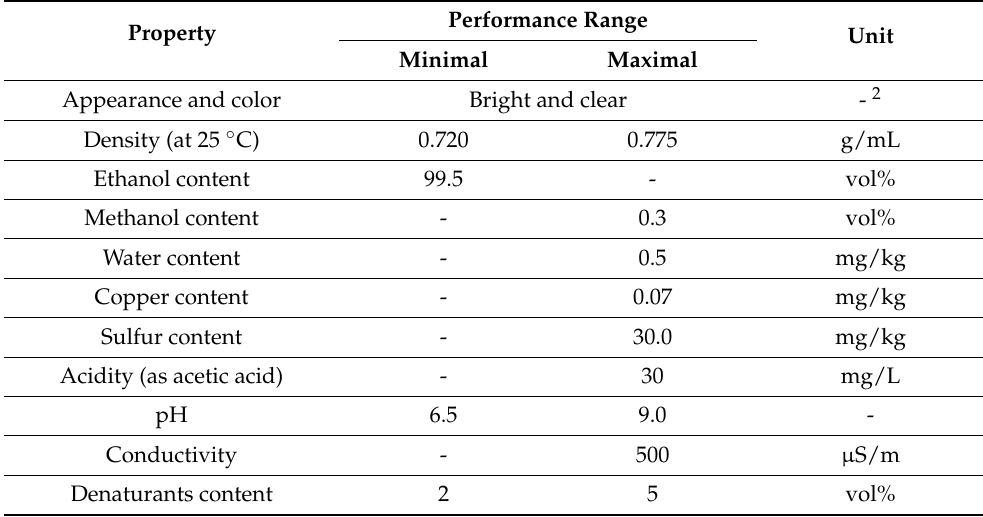
Table 3. Specifications of denatured ethanol fuel for blending with gasoline for use in an automotive spark-ignition fuel engine in Taiwan 1